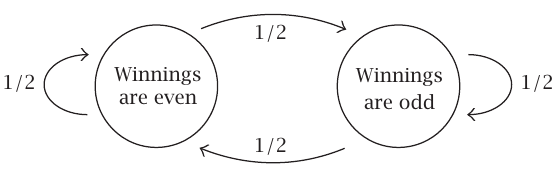
Figure 5.2 . A random choice between extreme games.